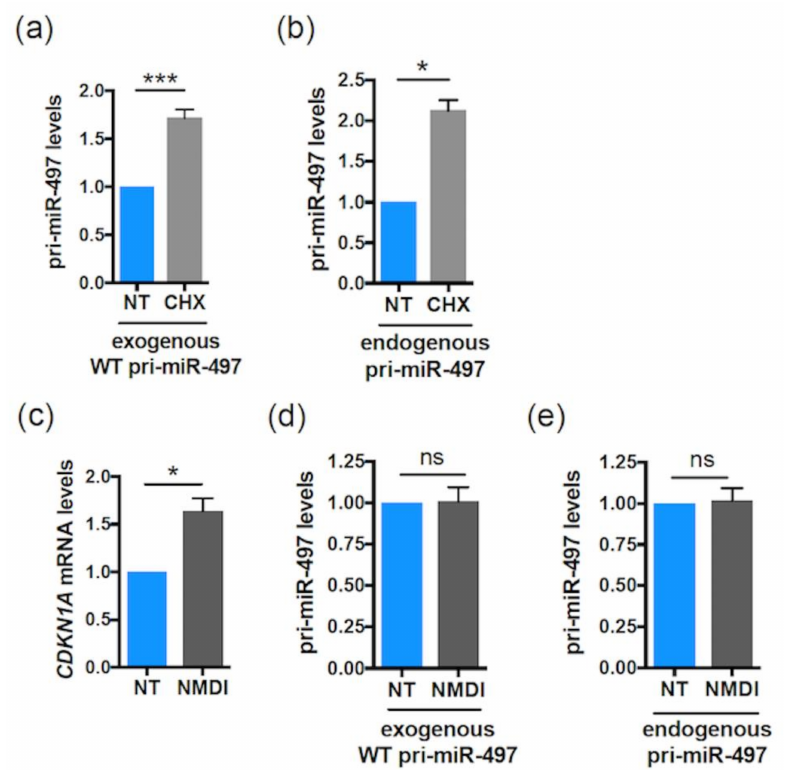
Figure 3. The Human pri-miR-497 is sensitive to CHX but not regulated by NMD. ( a , b ) Relative expression levels of WT pri-miR-497 transfected in HeLa cells ( a ) or endogenous pri-miR-497 ( b ) upon CHX treatment (50 µ g/mL for 1 h). Data are means ± S.E.M. ( a ) n = 6, ( b ) n = 3. ( c – e ) Relative expression levels of CDKN1A mRNA (used as positive control) ( c ) or WT pri-miR-497 transfected in Hela cells ( d ) or endogenous pri-miR-497 ( e ) upon NMDI14 treatment (50 µ M for 6 h). Data are means ± S.E.M. n = 4. ( a , d ) WT pri-miRNAs levels determined by qRT-PCR were normalized to EGFP and set to 1 for the untreated (NT) transfected cells. ( b , c , e ) The CDKN1A mRNA or endogenous pri-miR-497 levels determined by qRT-PCR were normalized to actin ( b ) or GAPDH ( c , e ) and set to 1 for the untreated cells. * p < 0.05, *** p < 0.0005, ns: not